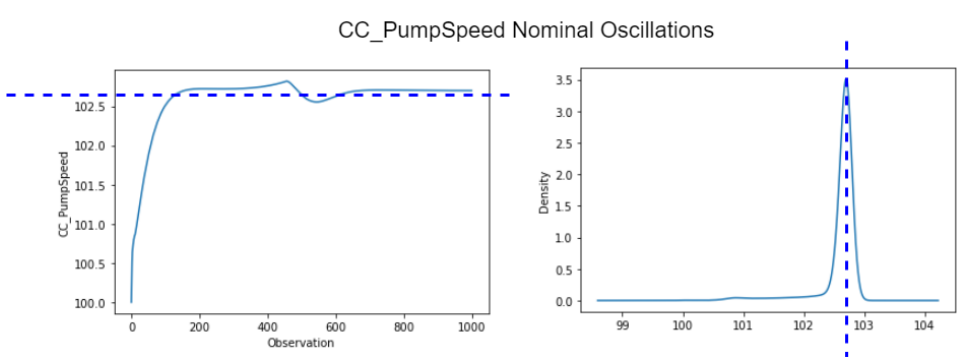
Figure 31. CC_PumpSpeed nominal oscillations (around